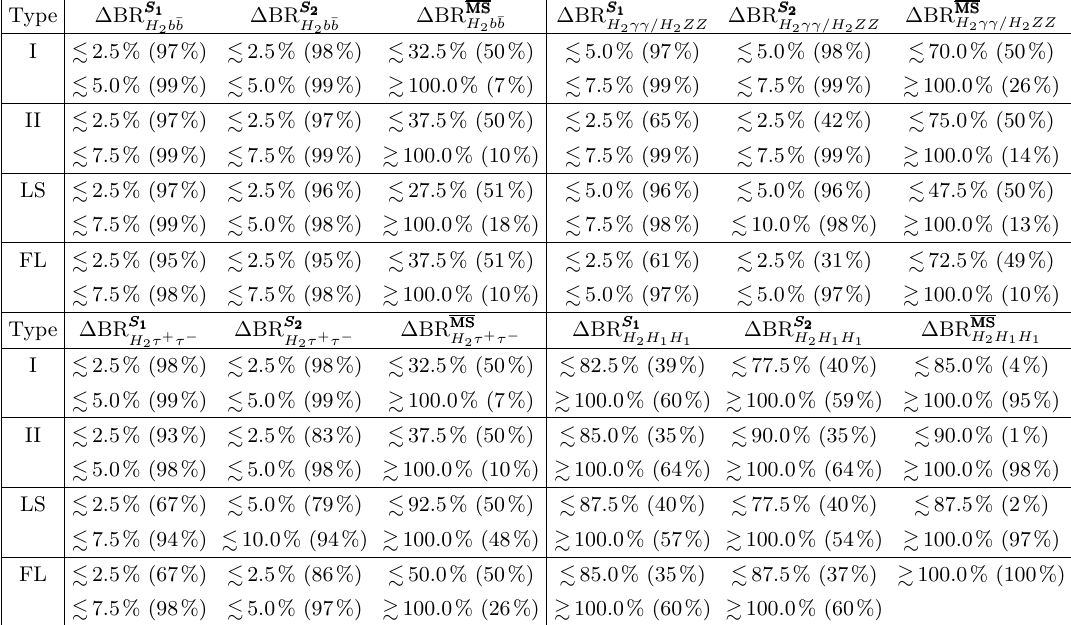
Table 17 . Relative size of the EW corrections to the BRs of the N2HDM SM-like H 2 in the four N2HDM types I, II, LS and